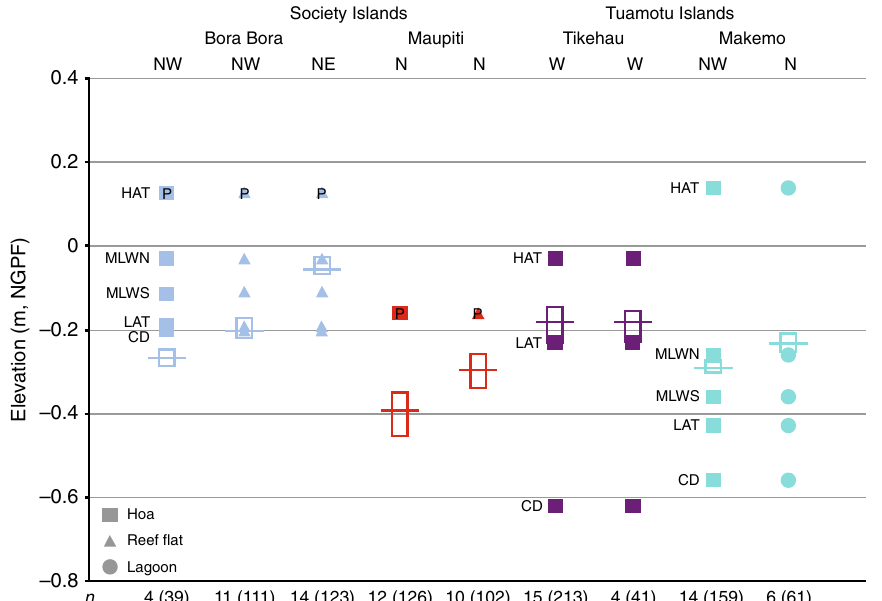
Fig. 3 Biological levels of modern microatolls in different depositional environments compared with tidal datums. The tidal datums are related to the NGPF. The open boxes represent the surveyed microatoll elevations at different sites from four islands, and the horizontal line indicates the mean biological level (MBL, see text). HAT, highest astronomical tide; MLWN, mean low water neaps; MLWS, mean low water springs; LAT, lowest astronomical tide; CD, chart datum. P, probe measurements (this study). See 'Methods' section for details on GPS microatoll positioning and probe measurements. The respective numbers ( n ) of microatolls and related GPS measurements (in brackets) per studied site are shown at the bottom of the fi